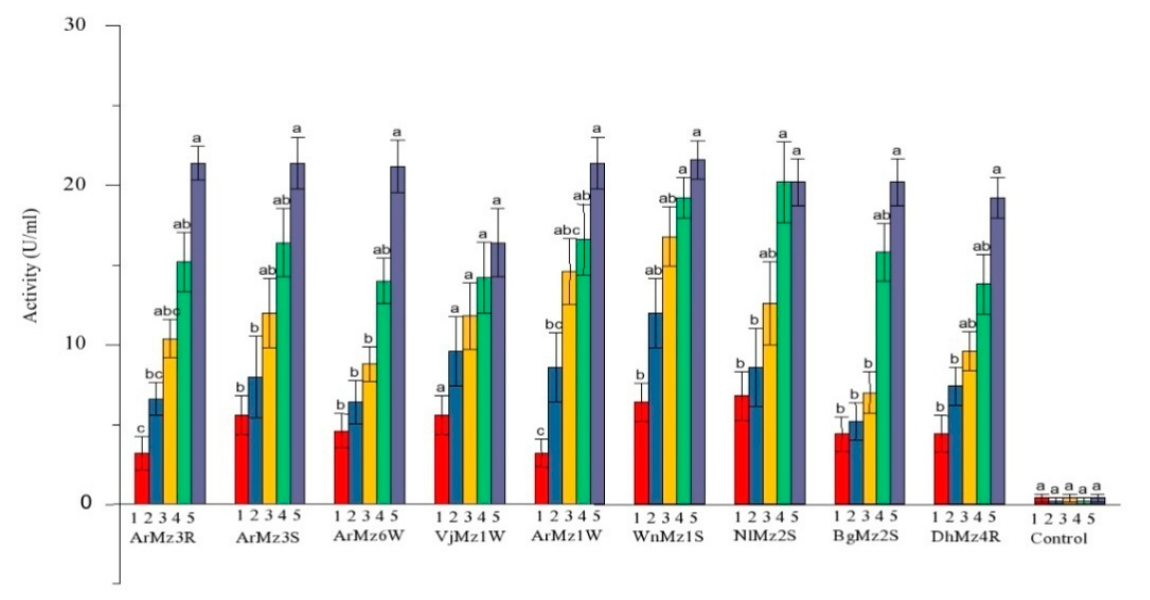
Figure 4. Activities of the chitinases (U/mL), Mean ± SE in the liquid culture media of the entomopathogenic fungi in the presence of H. puera cuticle. Statistical differences are shown by different letters (Tukey’s test, p < 0.001). Each color indicating different days of incubation (1st to 5th days).